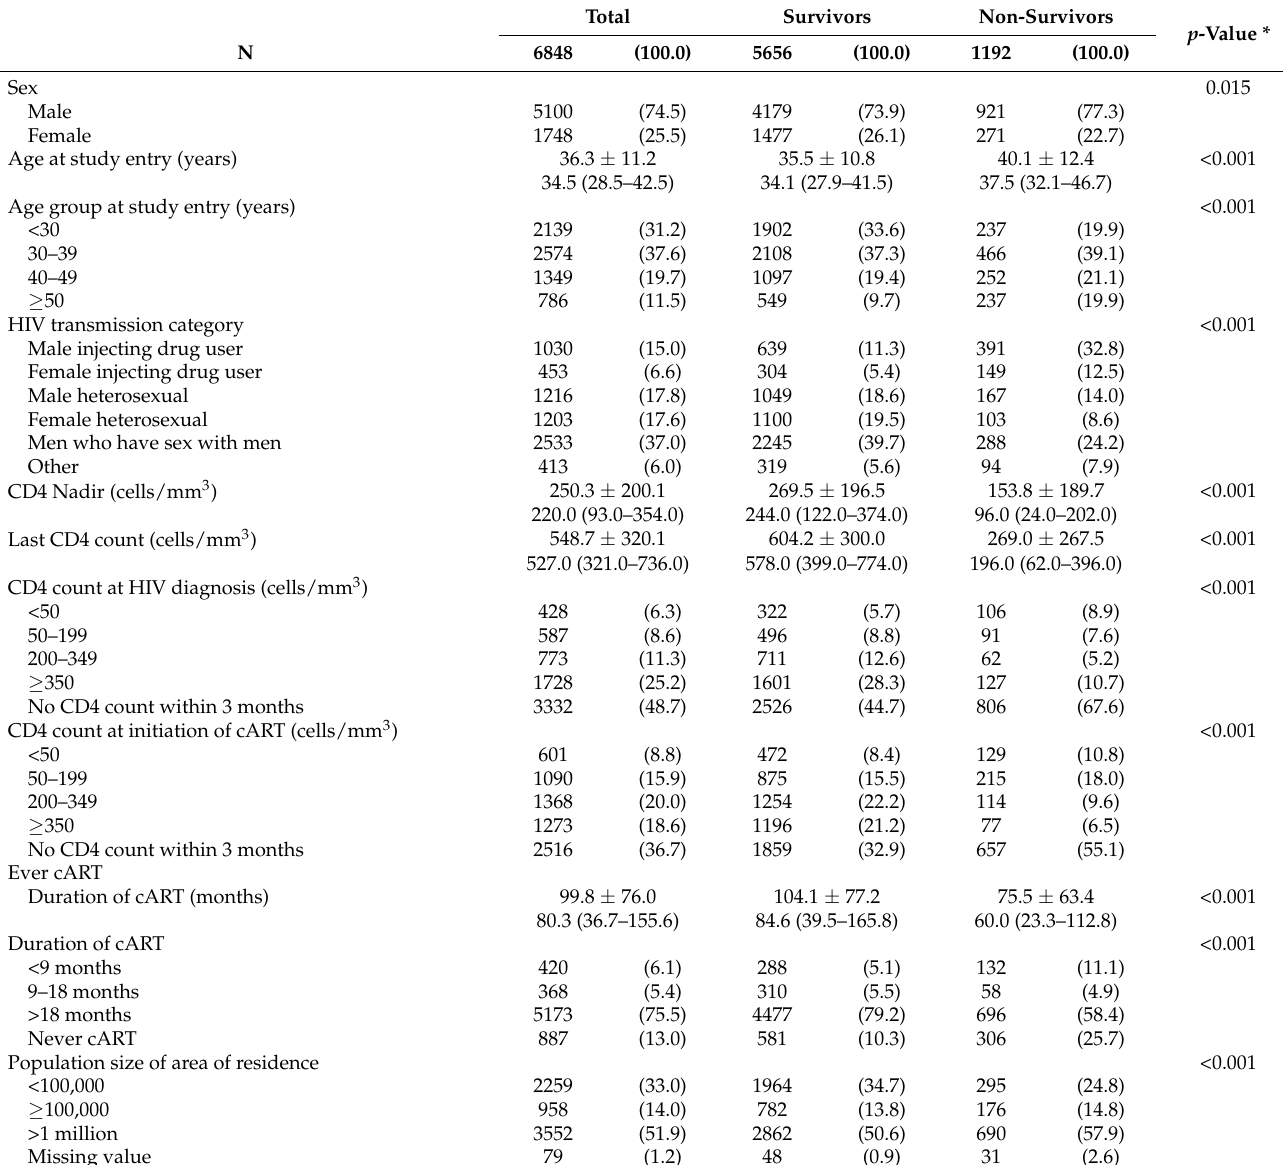
Table 1. Characteristics of